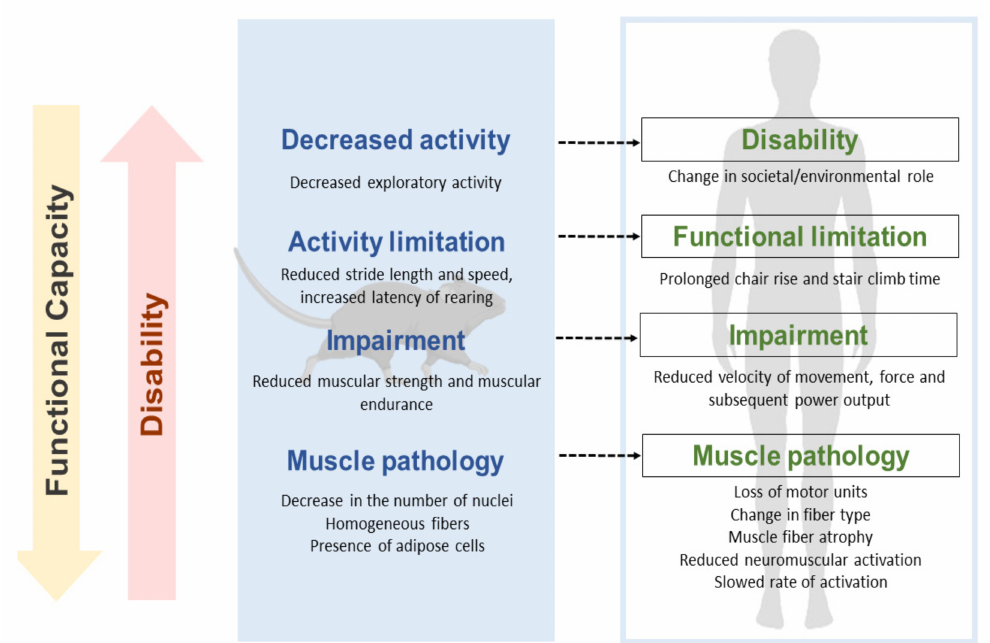
Figure 1. Proposal for a translational approach to motor dysfunction at different levels of disability. The figure details in a translational way the equivalence of the disability process from the 3xTg-AD mouse model to that expected in humans. It exemplifies a pathway that links pathology, deficiencies, functional limitations, and disability of gait and exploration (it has been adapted from Verbrugge and Jette, 1994; and Reid and Fielding, 2012)